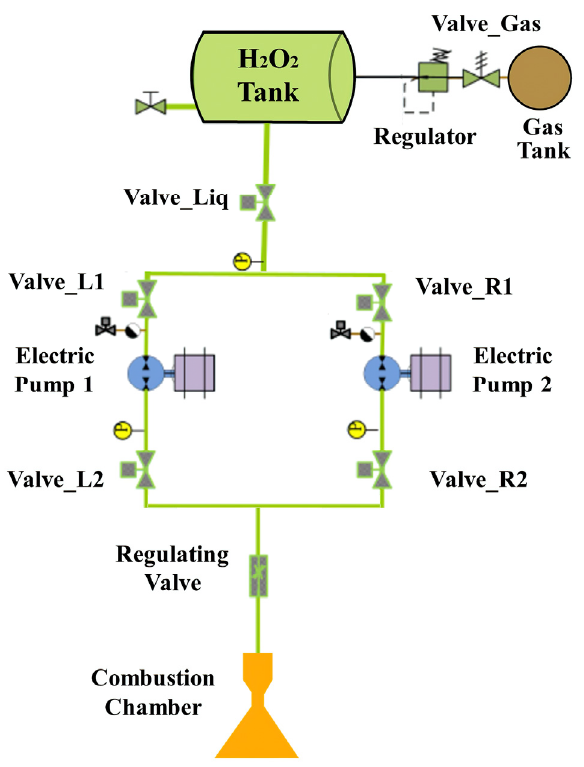
Figure 1. Schematic diagram of oxidant feed system of the engine.